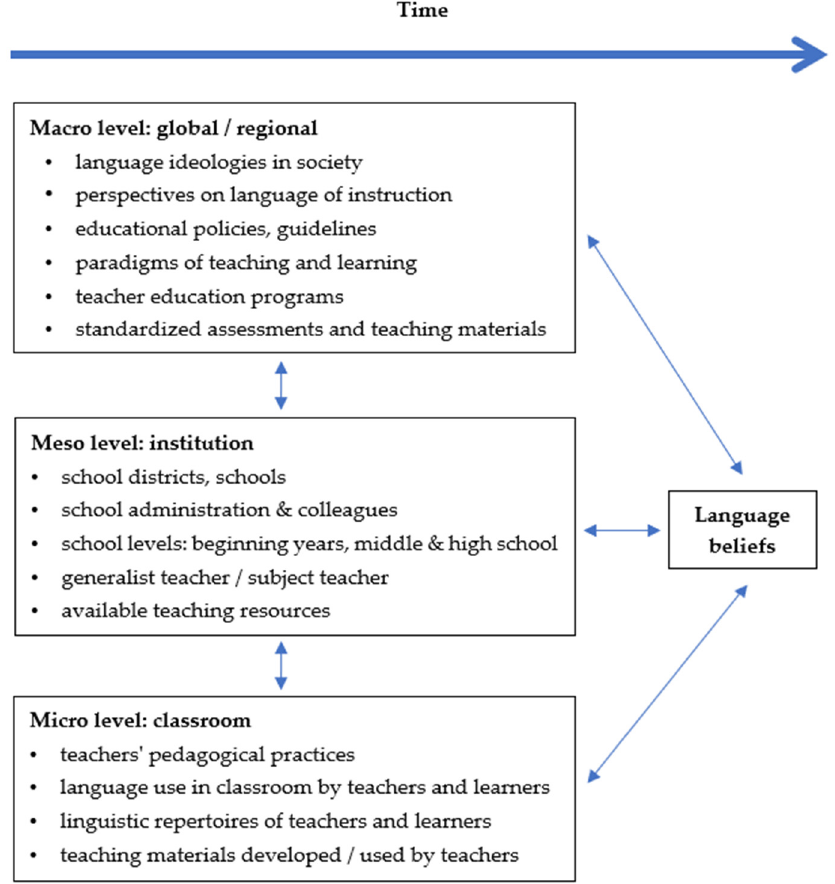
Figure 2. Contextual levels that impact teachers’ language beliefs.